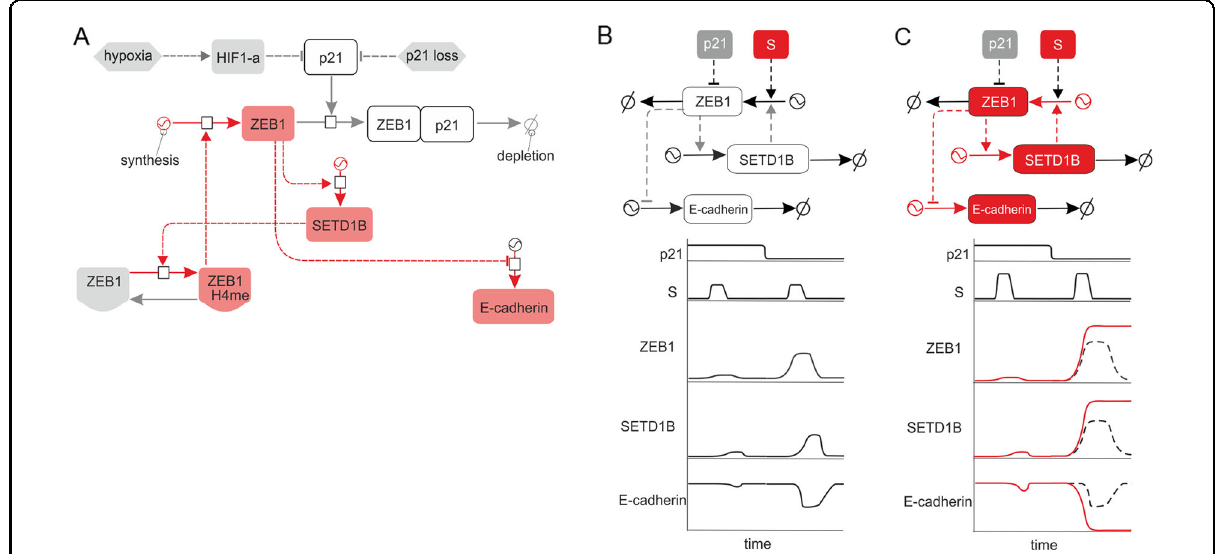
Fig. 6 ZEB1 regulates SETD1B via a regulatory circuit integrated by feedback and feedforward loops. a This system recapitulates in a regulatory network all the interactions relevant for the interplay between SETD1B and ZEB1 in the context discussed. The key element of the system is the double positive feedback loop between ZEB1 and SETD1B (ZEB1 → SETD1B → ZEB1/H3K4me3 → ZEB1). Through this loop each protein can reinforce the activity/expression of the other. This can amplify the activation of the circuit. b Under low transient stimulation (S) of ZEB1, the circuit responds with transient, low level activation even in the absence of p21. c The structure of the circuit suggests a medium but transient stimulation (S) of ZEB1. This activation can provoke an irreversible enhancement in the expression and activity of both molecules via triggering of SETD1B and feedback-regulating ZEB1 activation. This in turn may trigger the EMT phenotype by consistent, long-lasting inhibition of epithelial marker E- Cadherin. In solid red lines, we represent the long-lasting activation of the circuit, while the black dashed lines represent the transient activation of the circuit that would appear in case of disruption of the positive feedback